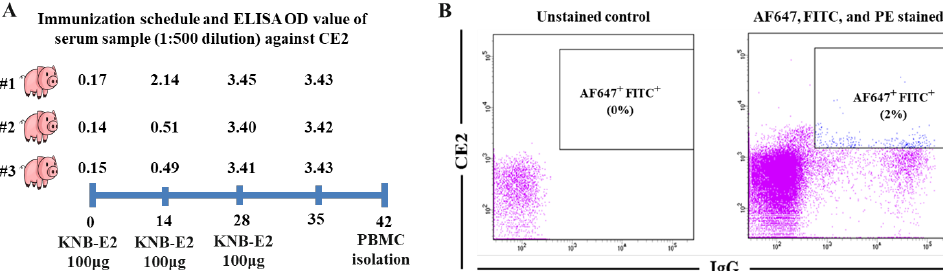
Figure 1. Isolation of CE2 + IgG + porcine B cells. ( A ) Immunization schedule and anti-CE2 antibody titers in serum samples collected at 0, 14, 28, and 35 DPV. ( B ) Distribution and proportion of CE2 + IgG + (AF647 + FITC + ) porcine B cells in peripheral blood of pig #1 as determined by FACS.